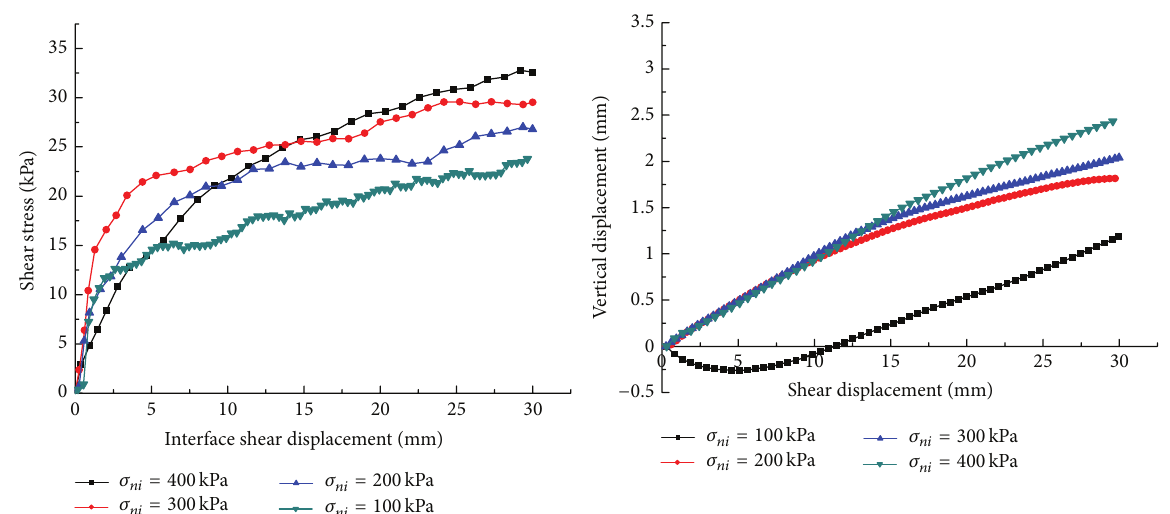
Figure 6: Test results for the interface between plate #0 and clay (applied normal stress of